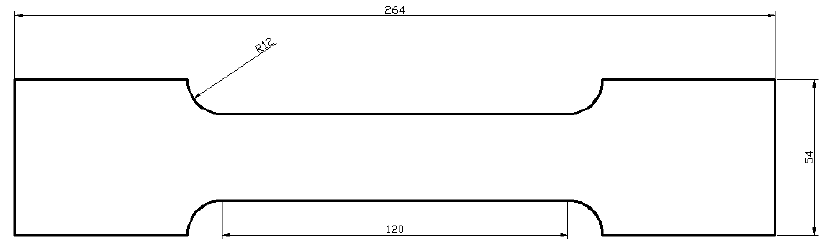
Figure 7. Schematic diagram of tensile sample (unit: mm).